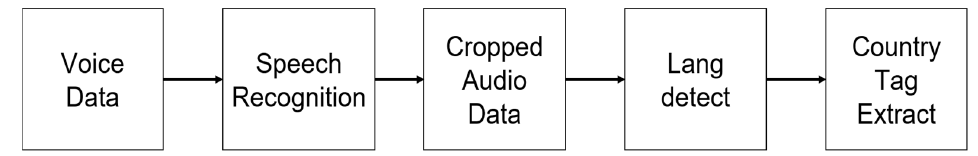
Figure 5. Country of manufacture analysis flow chart.